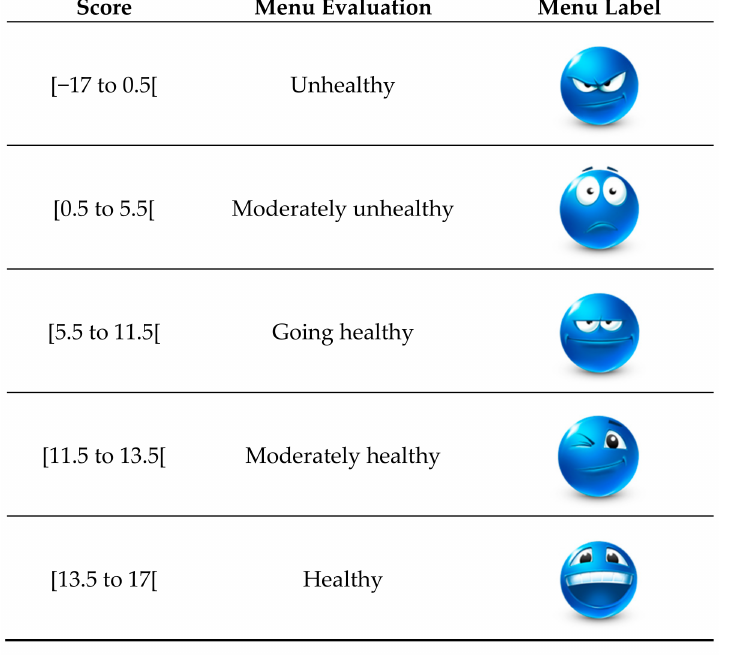
Figure 2. Proposal of simplified menu label based on the obtained KIMEHS. Icons credited to Emoticons Icons by ArtDesigner.lv, free for non-commercial use; commercial usage: allowed (backlink to http: // artdesigner.lv